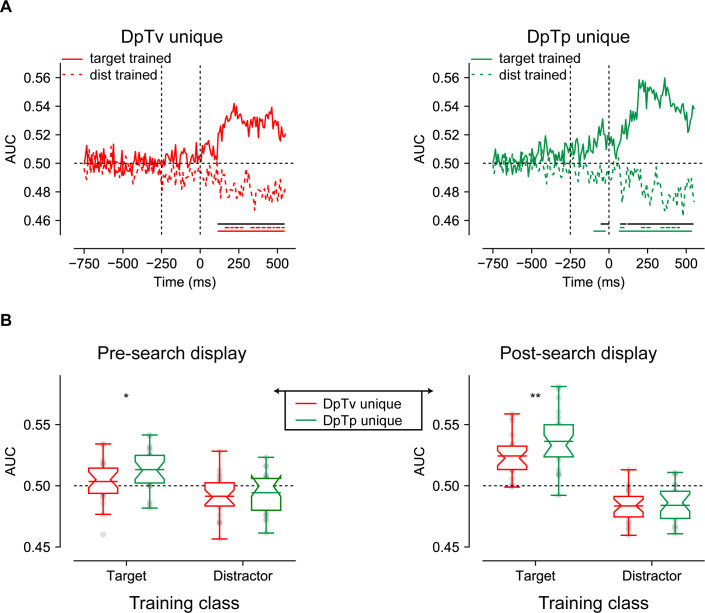
Multivariate decoding of the target using either weights from a model trained on targets spatial frequencies and distractor spatial frequencies.(A) AUC scores of DpTv unique (left) and DpTp unique (right) decoding across time. Colored bars on the x-axis indicate clusters where conditions differ significantly from chance after cluster correction (p<0.05). Solid black lines indicate clusters with a significant difference between models trained on targets and distractors after cluster correction (p<0.05). (B) Averaged auc scores during the pre_search display (−250 to 0 ms; left) and the post-search display (0–550 ms; right) visualized by notched boxplots with solid horizontal lines corresponding to the mean. Horizontal black dashed lines across plots indicates chance performance, whereas the vertical dashed black lines in the upper plots indicate the onset of placeholder (−250 ms) and the search display (0 ms).